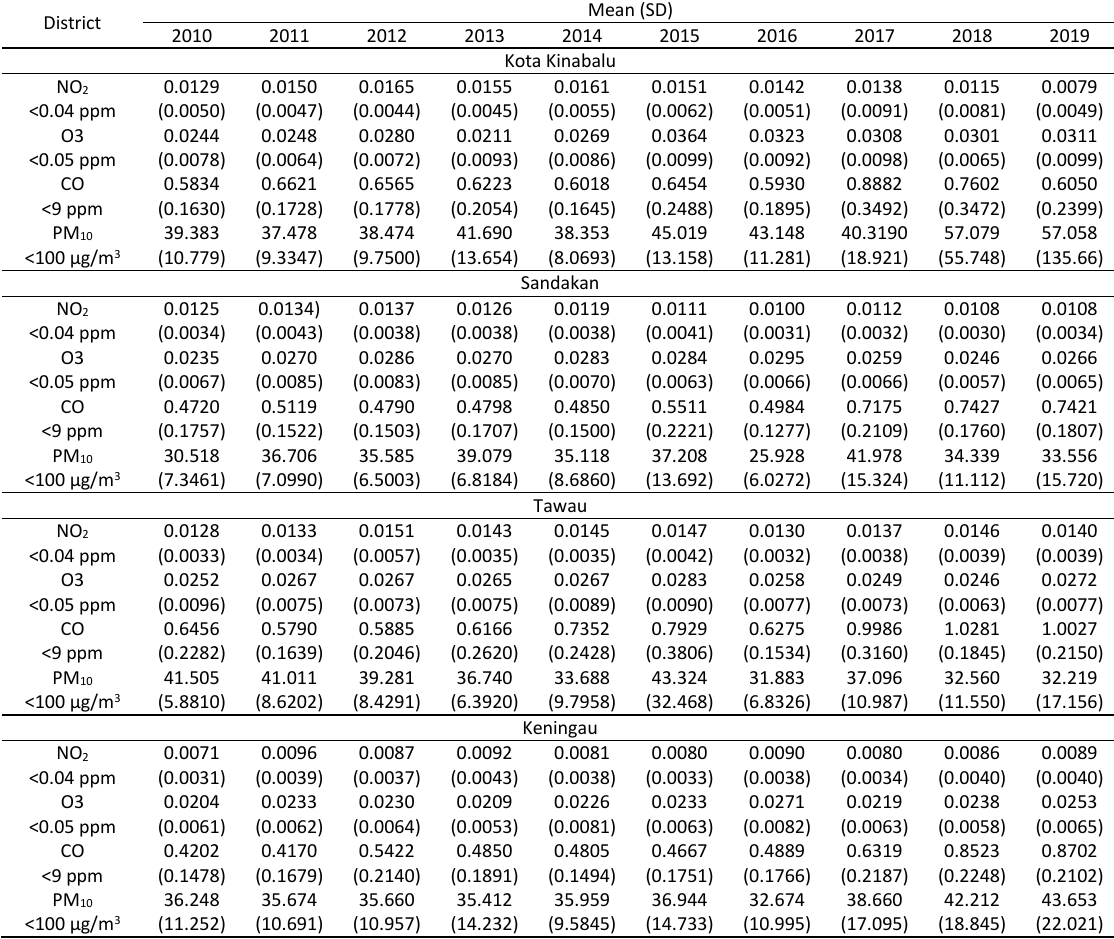
Table 3: Air pollutants in Sabah 2010–2019